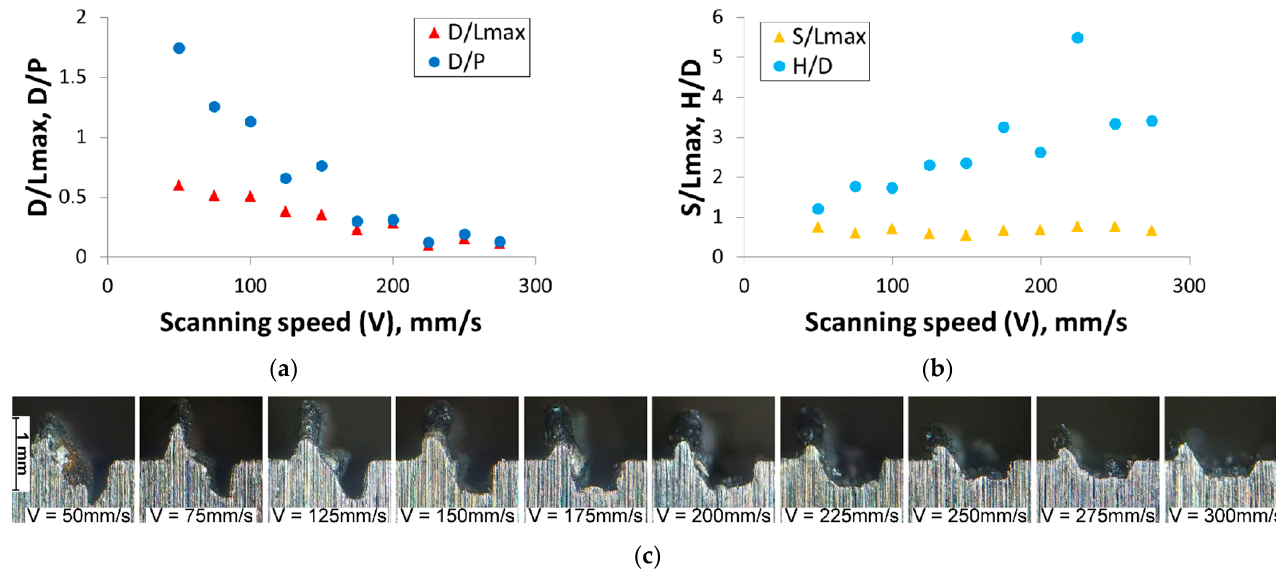
Figure 7. Graphs of the dependences of the investigated parameters ( a ) D, P and ( b ) S, H speed of the beam ( V ), as well as ( c ) the transverse sections of the grooves obtained at different values of V (50–275 mm/s).